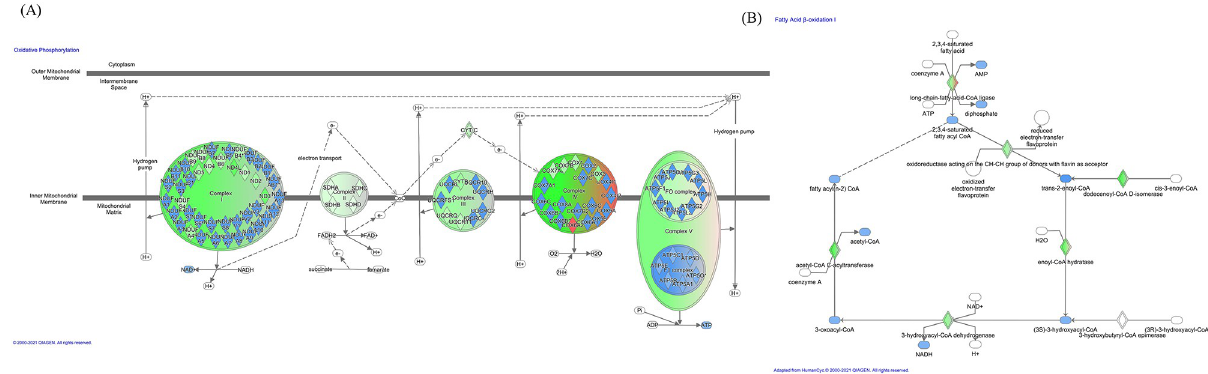
Fig 8. Ingenuity pathway analyses of oxidative phosphorylation (A) and fatty acid β -oxidation I (B) in the MLN of the IP group at 6 weeks PI. Nodes are colored based on gene expression along with predictions of upstream and downstream molecules. A gene in red indicates upregulation, a gene in green indicates downregulation, a gene in orange indicates predicted activation, and a gene in blue indicates predicted inhibition. Uncolored nodes indicate that genes were not differentially expressed in the pathway shown.